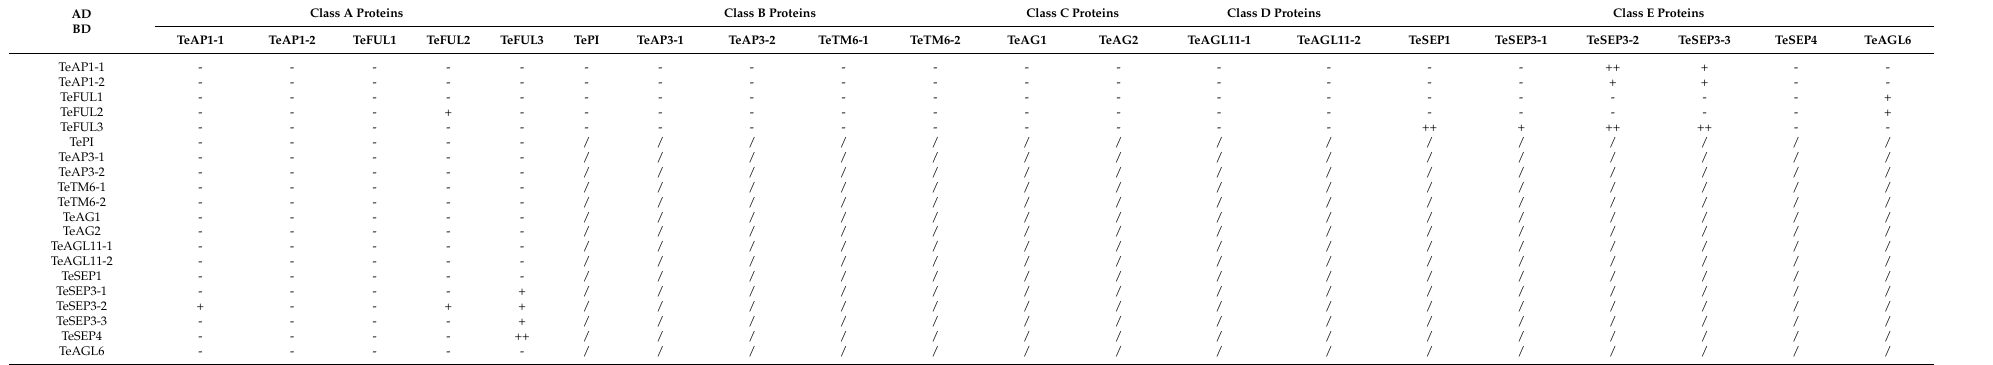
Table 1. Interactions of Marigold TeAP1/FUL proteins with classes A, B, C, D, and E proteins detected by yeast two-hybrid